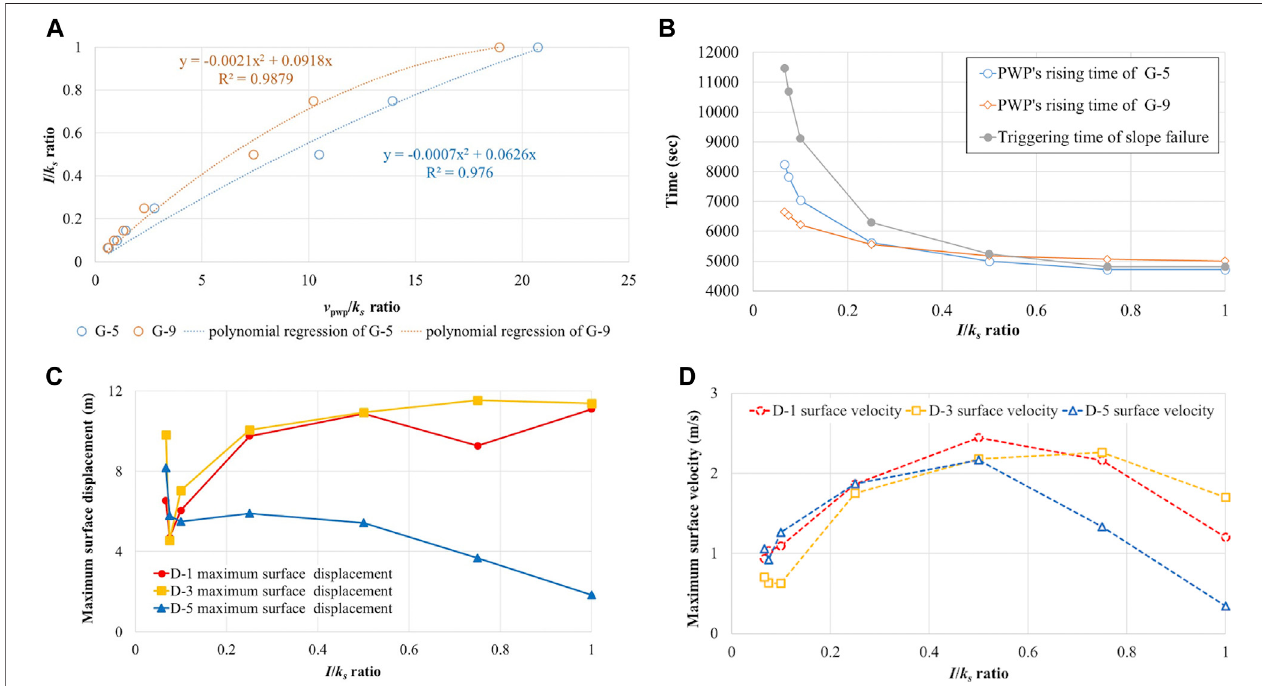
FIGURE7| Effectsofrainfallintensityonarainfall-inducedlandslide: (A) changesinthe v PWP / k s ratio; (B) changesinthetimeatwhichthePWProseandthetimeat which slope failure was triggered; (C) changes in the maximum surface displacement; (D) changes in the maximum surface velocity.